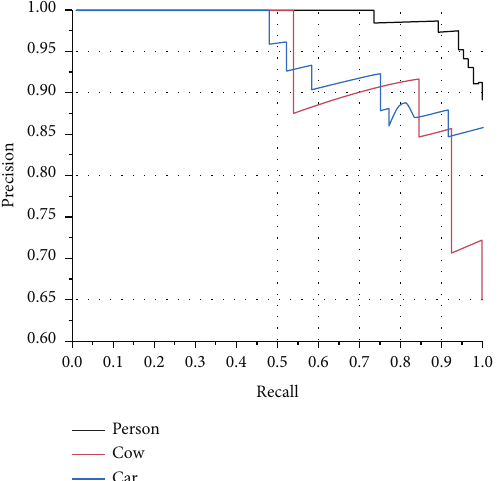
Figure 10: Abnormal video classification P-R